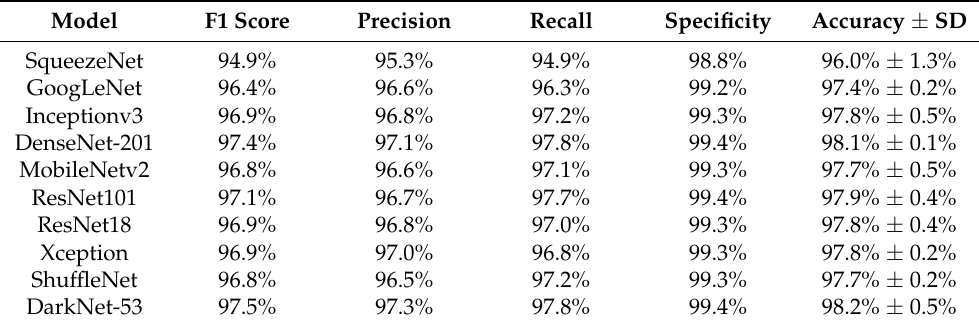
Table 3. The mean overall F1 score, precision, recall, specificity, and accuracy using 70% of the data for training. The results are an average of 10 runs.